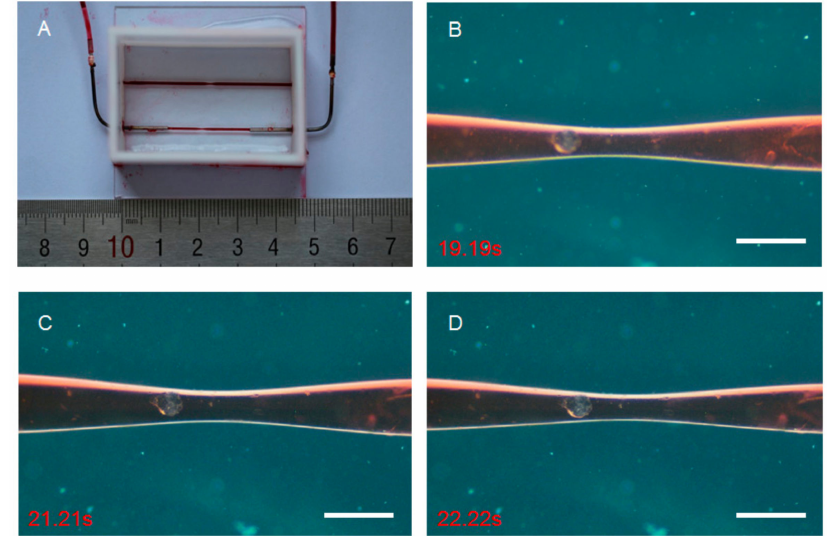
Figure 2. The microchip and liquid transport properties of artificial blood vessel: ( A ) The microchip perfused with oil red O, showing the liquid transport properties of the microchannel. ( B – D ) The original ( B ), expanded ( C ), and contracted ( D ) status of the microchannel. Scale bar, 100 µ m.